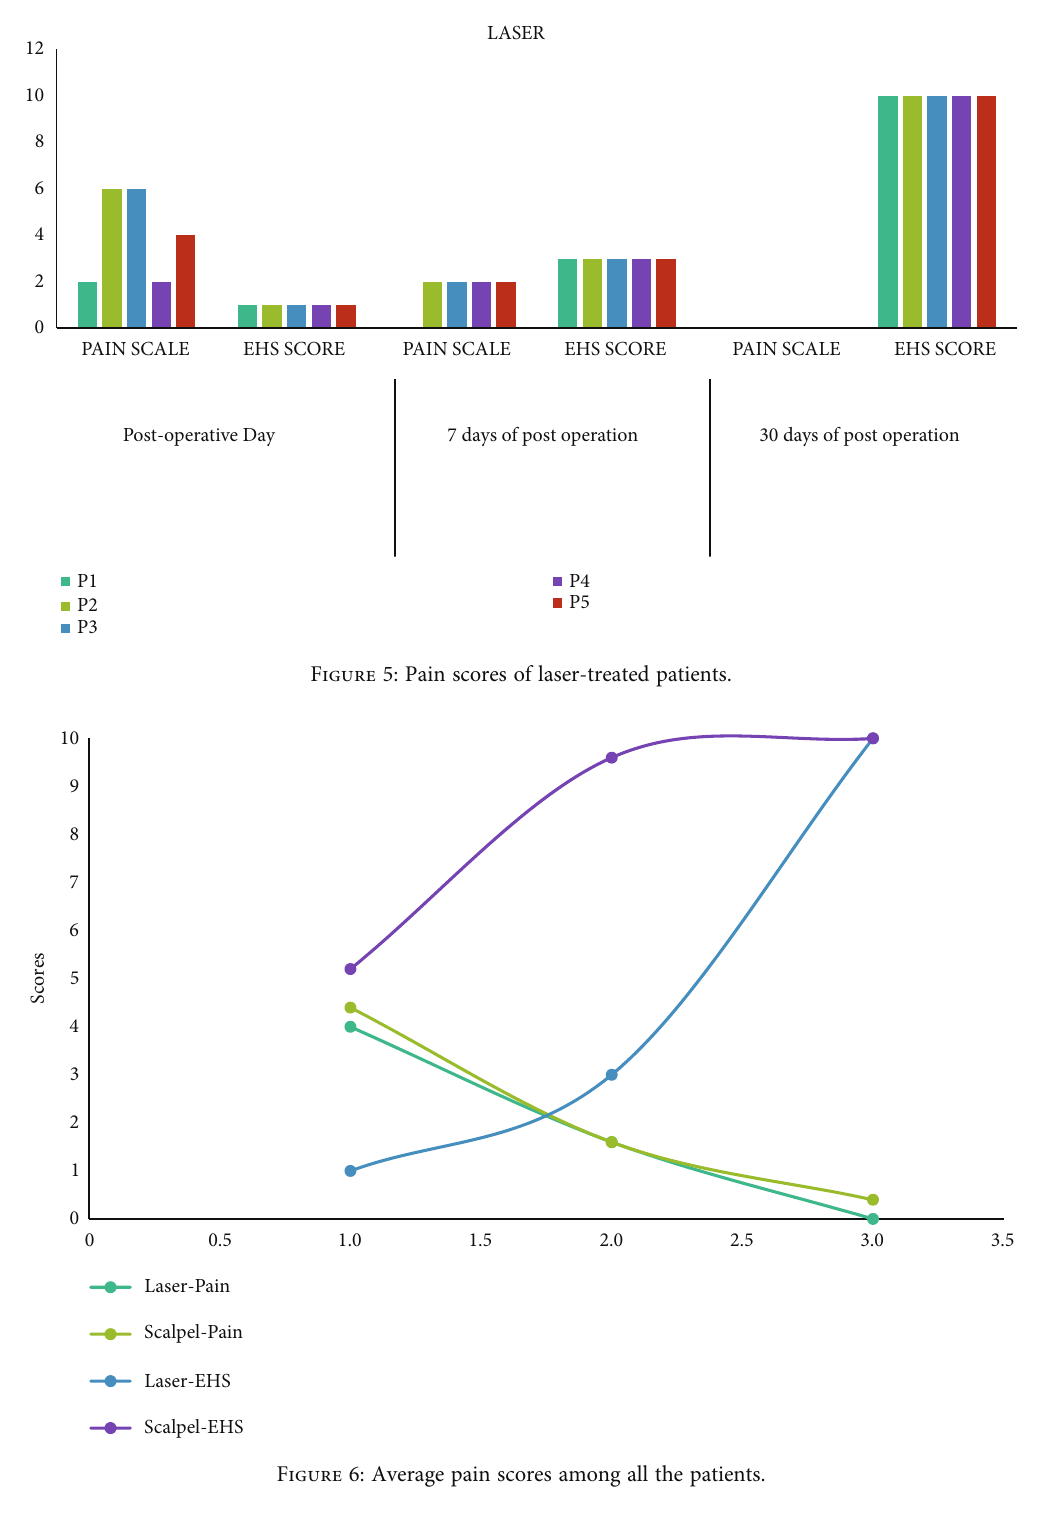
Figure 6: Average pain scores among all the